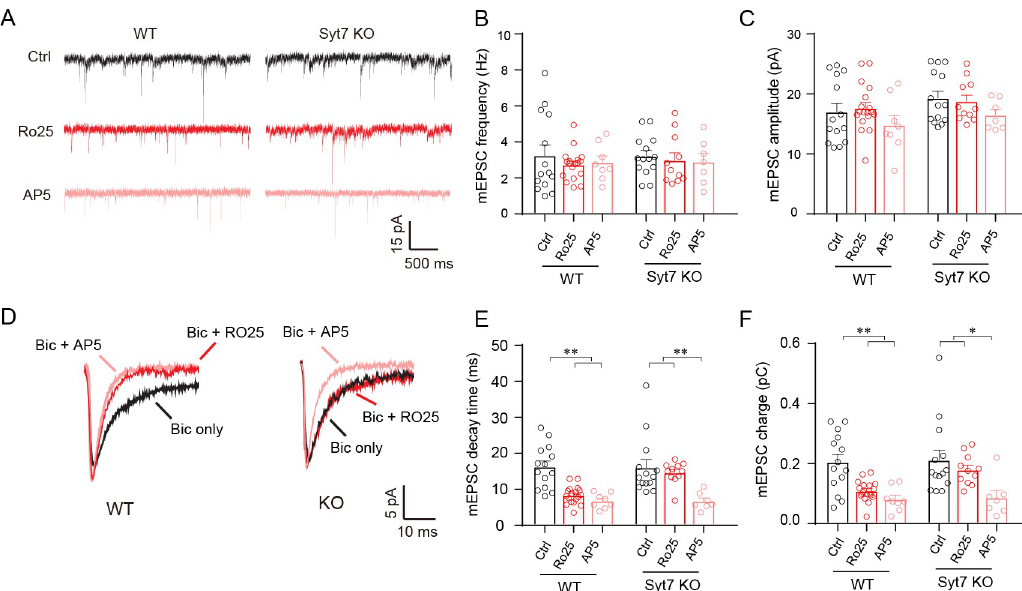
Fig 2. Syt7 triggered spontaneous glutamate release specifically activates GluN2B-NMDARs. ( A ) Sample traces of AMPAR/ NMDAR-mEPSCs in hippocampal slices of WT and Syt7 KO neurons. ( B, C ) Bar graphs summarizing the frequency ( B ) and amplitude ( C ) of AMPAR/NMDAR-mEPSCs. ( D ) Average traces of AMPAR/NMDAR-mEPSCs. ( E, F ) Bar graphs summarizing the decay time ( E ) and total charge ( F ). ( A–F ) WT, n = 14/18/8; KO, n = 14/11/7. Student t test; � P < 0.05; �� P < 0.001; error bars, SEM. The numerical data underlying this figure are included in S1 Data. AMPAR, AMPA receptor; KO, knockout; mEPSC, miniature excitatory postsynaptic current; Syt7, synaptotagmin-7; WT, wild-type.